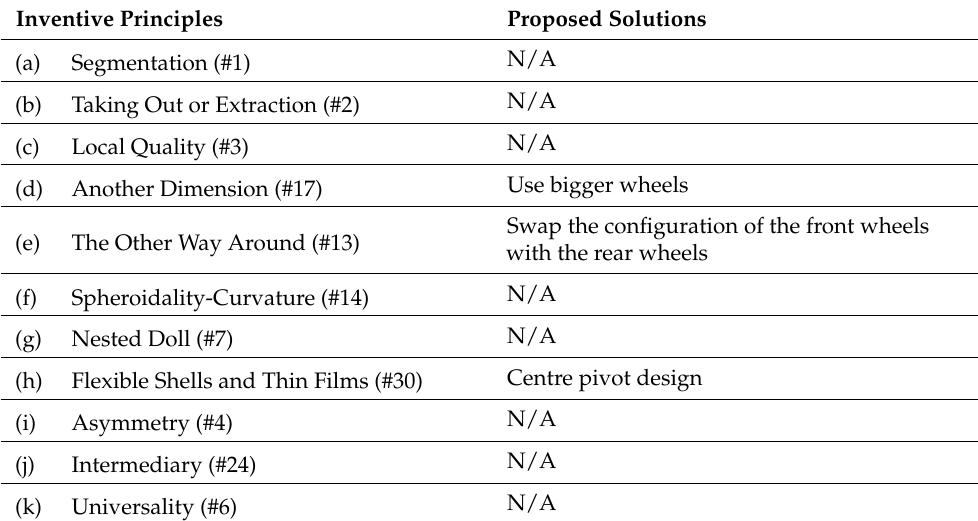
Table 6. Inventive principles for separation in space and the proposed solutions.